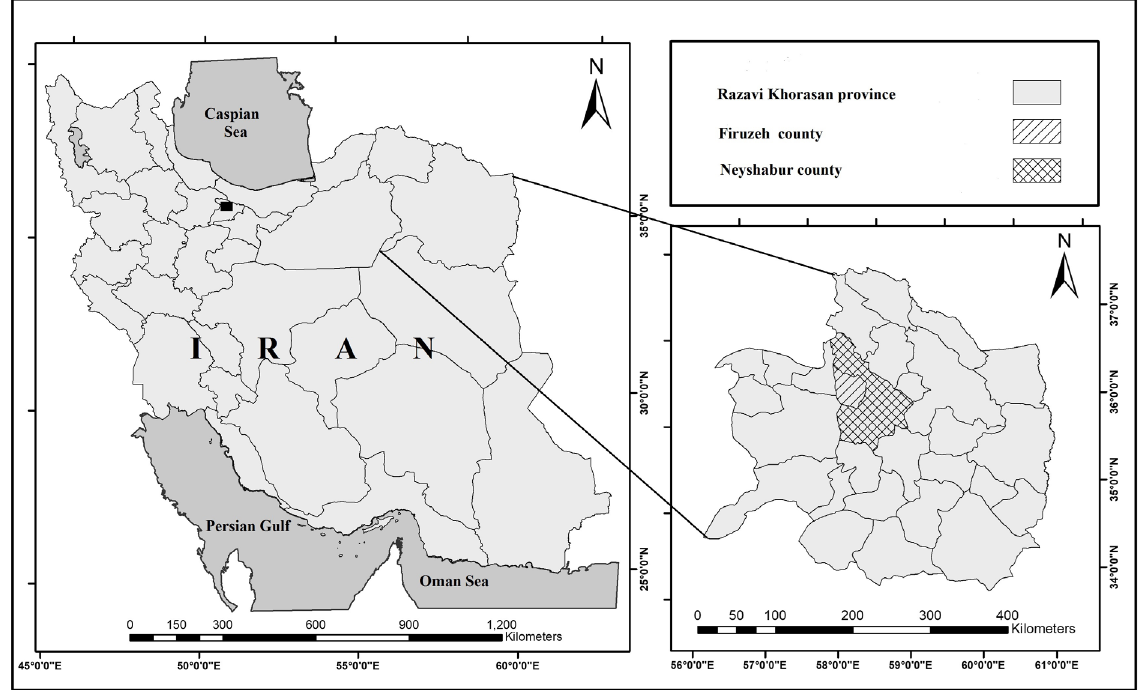
Figure 1. Geographical location of Neyshabur and Firuzeh Counties, Razavi Khorasan Province,